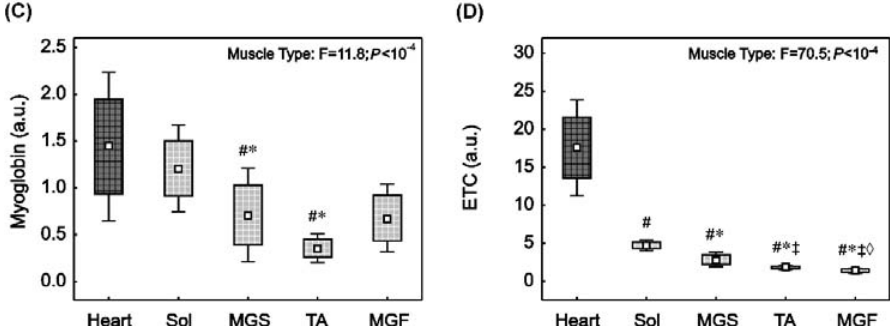
Figure 1. Nitrite, nitrate concentrations and nitrite reductase contents in rat striated muscles with varied muscle fibre type composition. Nitrite ([NO 2 − ], ( A )), nitrate ([NO 3 − ], ( B )) as well as myoglobin ( C ) and electron transport chain (ETC) proteins content ( D ) in the heart (dark square) and in the locomotory muscles (bright squares) i.e., soleus (Sol), slow part of medial gastrocnemius (MGS), tibialis anterior (TA) and fast part of medial gastrocnemius (MGF). Boxes and whiskers represent, correspondingly, the 95% confidence intervals for means and the standard deviations in samples of 12 animals for each studied muscle tissue (i.e., heart, Sol, MGS, TA and MGF). The impact of muscle type on the analysed variables is presented. Results of one ‐ way ANOVA and Tukey post ‐ hoc are shown in ( C ), whereas Welch ANOVA and post ‐ hoc Games–Howell results are presented in ( A , B , D ). # denotes a signi fi cant di ff erence to the heart; * denotes a signi fi cant di ff erence to Sol; ‡ denotes a significant difference to MGS; ◊ denotes significant difference to TA.